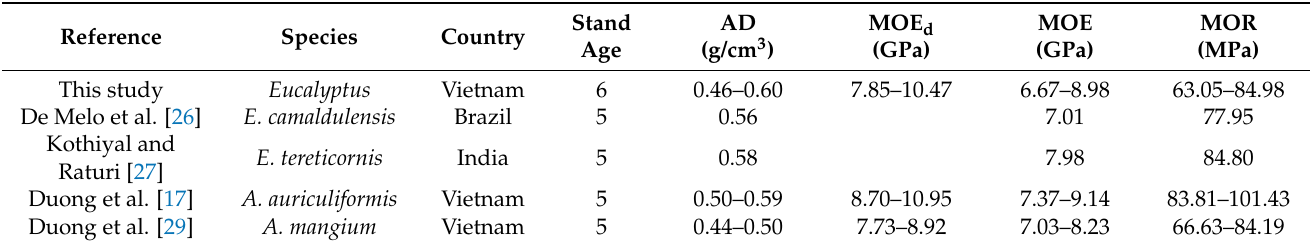
Table 4. Summary of air-dry density and mechanical properties for the Eucalyptus clones in this study and related studies.